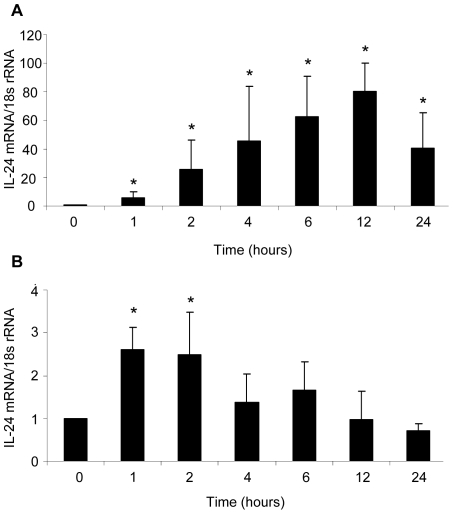
Time course studies of IL-24 mRNA expression.NHEK were incubated with (A) anisomycin (300 ng/ml) or (B) IL-1β (10 ng/ml) for the indicated time periods and IL-24 mRNA expression levels (relative to housekeeping gene 18s rRNA) were determined using quantitative RT-PCR. *p<0.05 compared with cells harvested before stimulation (0 hours) (A, n = 6 cultures, B, n = 5 cultures). Bars indicate mean ± SD.